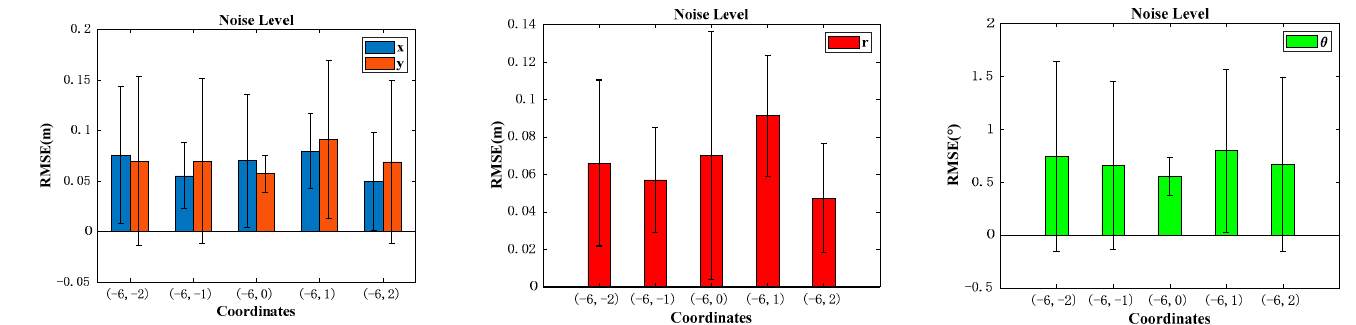
Figure 15. The positioning noise level of electromagnetic positioning, where the x-coordinate is equal to − 6 m.